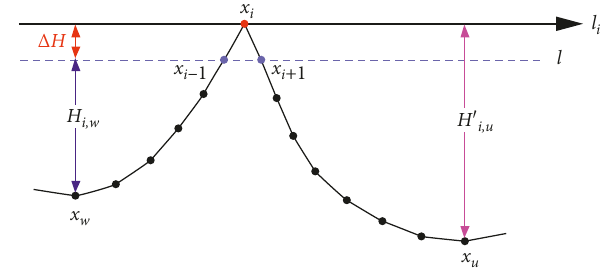
Figure 2: Accurate height values for the sample point x